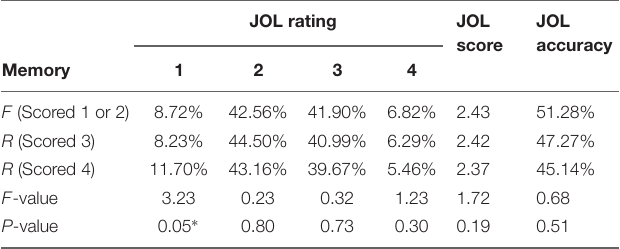
TABLE 1 | Judgment of learning (JOL) rating as a function of actual memory